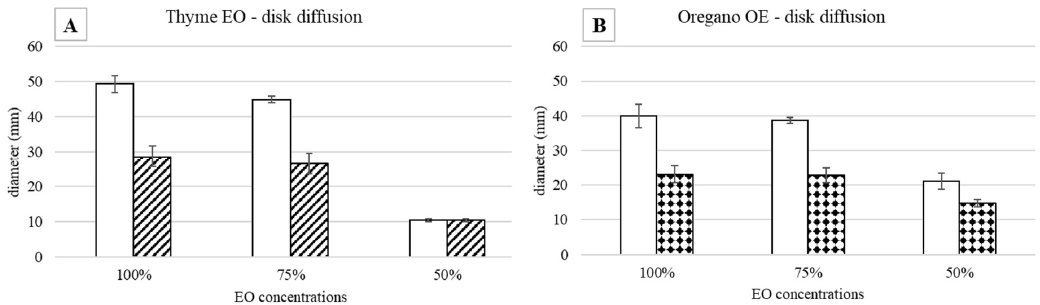
Figure 1. Agar disk diffusion test against S. epidermidis incubated at 37 °C: halo diameters measured after 24 (white bars) and 48 (drawn bars) h of incubation in the presence of ( A ) thyme and ( B ) oregano EOs.